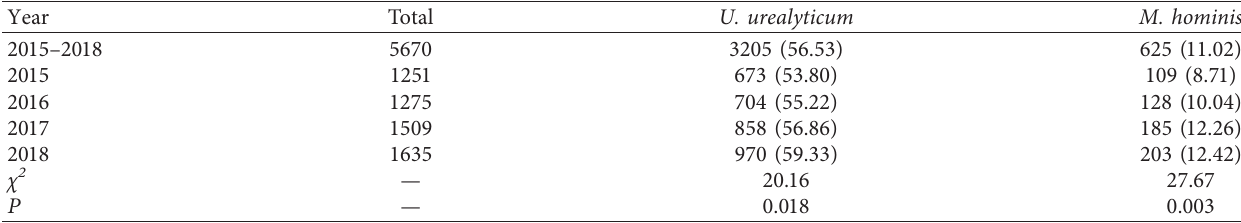
Table 3: Yearly distributions of U. urealyticum and M. hominis from 2015 to 2018.